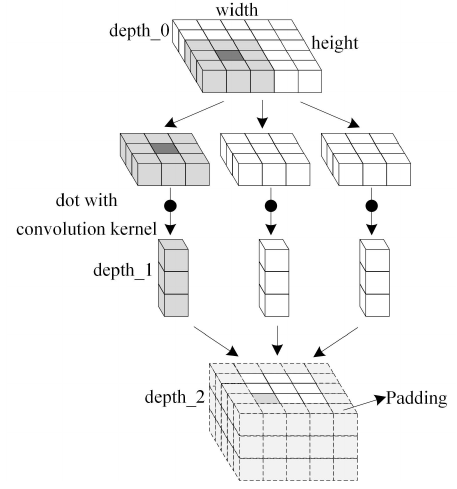
Figure 1. Representation of convolution.